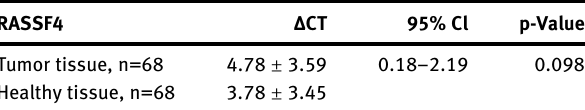
Table  : RASSF  Δ CT values in patients and controls. RASSF 